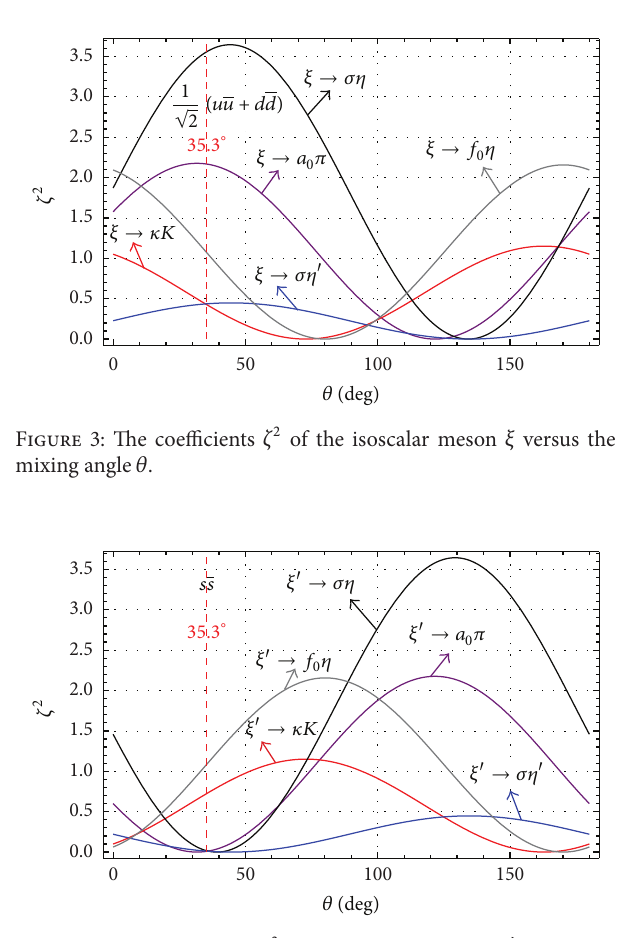
Figure 4: The coefficients 𝜁 2 of the isoscalar meson 𝜉 󸀠 versus the mixing angle 𝜃 .